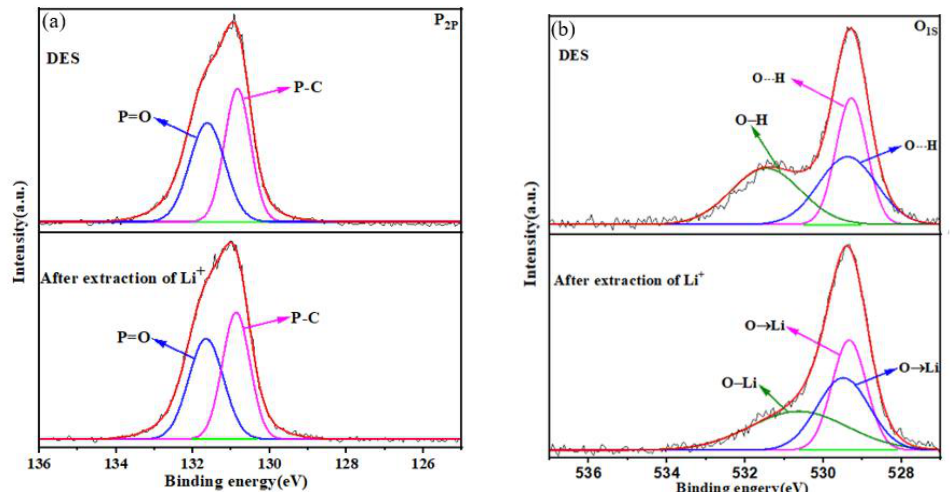
Figure 5. ( a ) P 2p XPS spectra of the DES extractant (molar ratio: HTTA/TOPO = 2/1). ( b ) O 1s XPS spectra of the DES extractant.